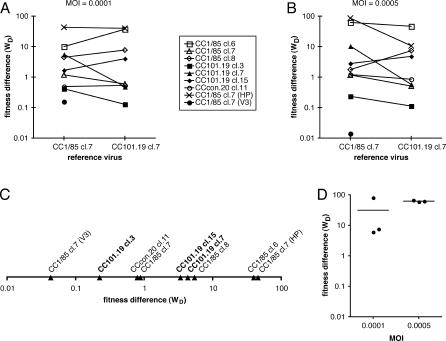
Replicative Fitness of the Clonal Env-Chimeric Viruses Relative to the CC1/85 cl.7 and CC101.19 cl.7 Reference Viruses(A and B) The replicative fitness of each vifX clonal virus relative to the indicated vifY reference virus was calculated from the mean virus proportions from three to seven independent competition experiments, and is shown for MOIs of (A) 0.0001 and (B) 0.0005. Fitness differences < 1 indicate the vifX virus is less fit than the vifY reference virus, > 1 that the vifX virus is the more fit. The vifX viruses used were: CC1/85 cl.6 (open squares), CC1/85 cl.7 (open triangles), CC1/85 cl.8 (open diamonds), CC101.19 cl.3 (filled squares), CC101.19 cl.7 (filled triangles), CC101.19 cl.15 (filled diamonds), CCcon.20 cl.11 (open circles), CC1/85 cl.7 (HP) (X symbol), and CC1/85 cl.7 (V3) (filled circles).(C) The plotted fitness differences were averaged between reference viruses and MOIs from (A) and (B). Thus, the fitness differences shown are all relative to an arbitrary reference point (= 1.0). The three clones from the AD101-resistant CC101.19 isolate are shown in bold (C).(D) Independent fitness difference determinations generate reproducible results. The WD values for CC1/85 cl.6 vifX relative to CC1/85 cl.7 vifY are plotted for three individual experiments at the MOIs indicated. This pairing was chosen because of the large difference in fitness between them. The WD values were determined from the proportion of each virus within a single experiment. The bars represent the means of these WD values (31 and 63 at MOIs of 0.0001 and 0.0005, respectively). The same data were analyzed in (A) and (B) by taking the average of the proportions between the three experiments before calculating the WD, thereby minimizing the influence of outliers. The WD values derived from (A) and (B) were 10 and 63 at MOIs of 0.0001 and 0.0005, respectively.